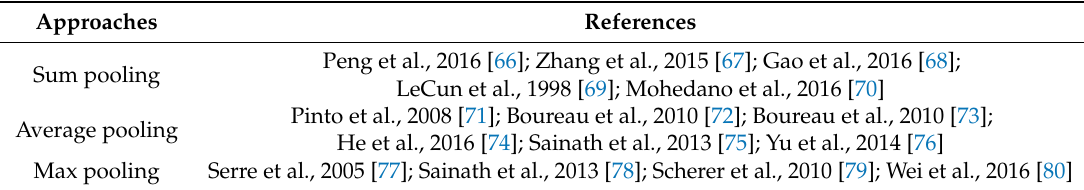
Table 3. Popular approaches and corresponding references for general